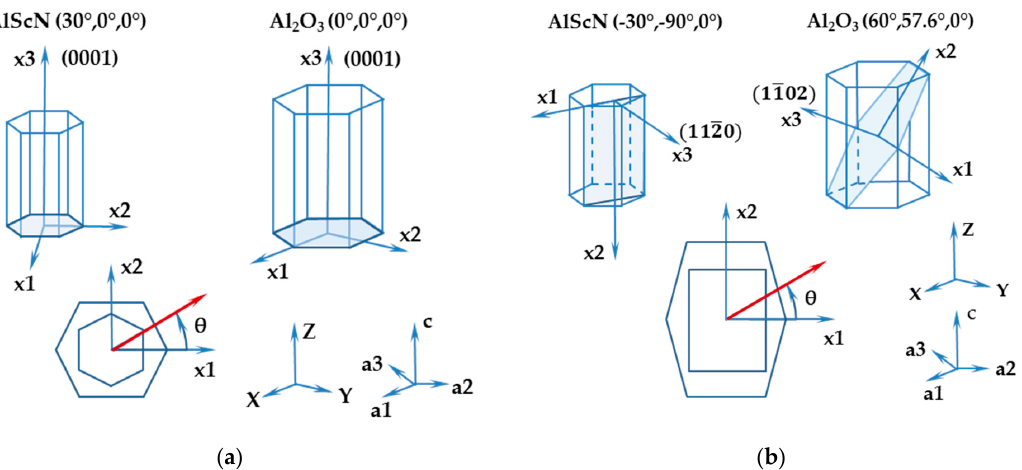
Figure 1. Crystal cuts of Al 2 O 3 substrate and AlScN film, defined in the hexagonal crystal system (a1,a2,a3,c) and with the help of the two first Euler angles λ and μ (rotation with respect to Cartesian coordinate system XYZ). The third Euler angle θ defines the direction of SAW propagation (red arrows) on the surface planes (x1x2). ( a ) The c-plane (0001) cuts of both film and substrate; ( b ) a- plane AlScN(11-20) film on the r-plane Al 2 O 3 (1-102) substrate.